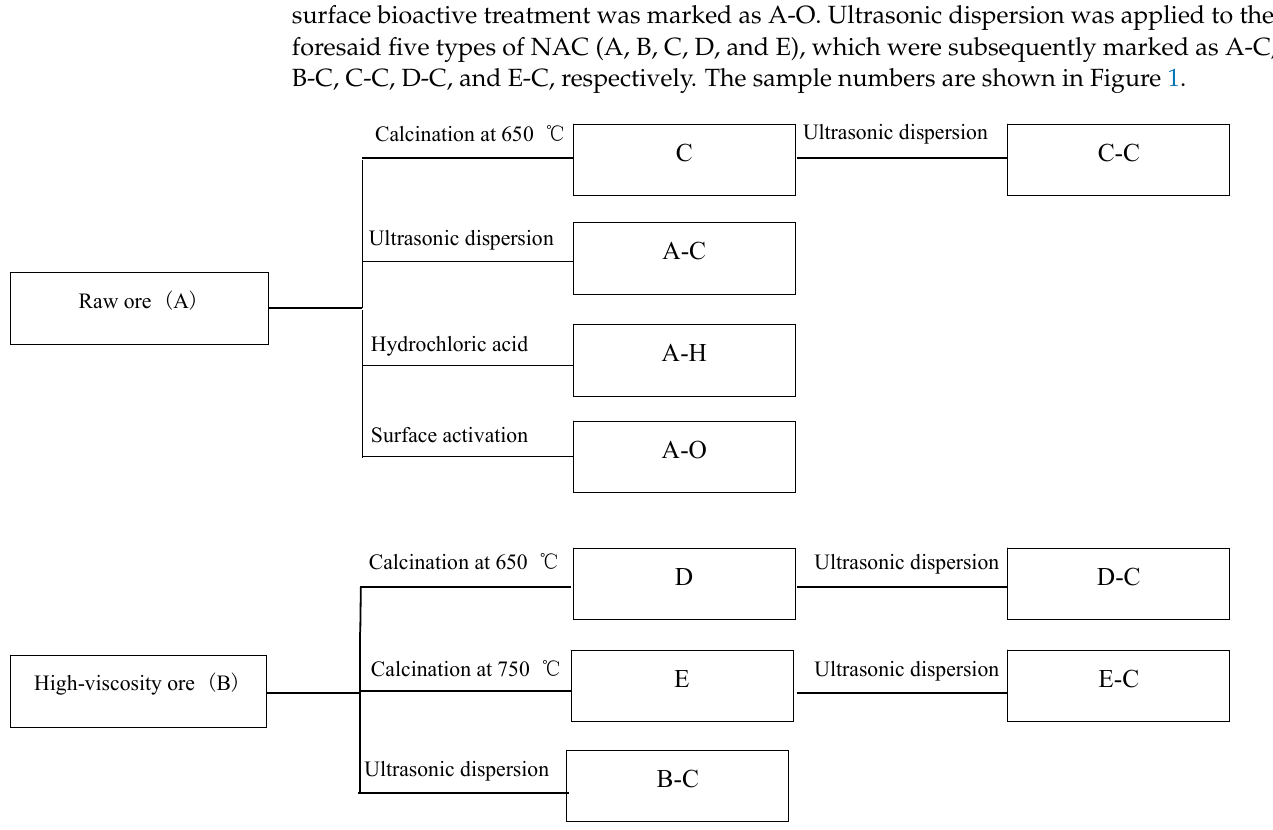
Table 2. Physicalindex of stearyl trimethyl ammonium chloride.